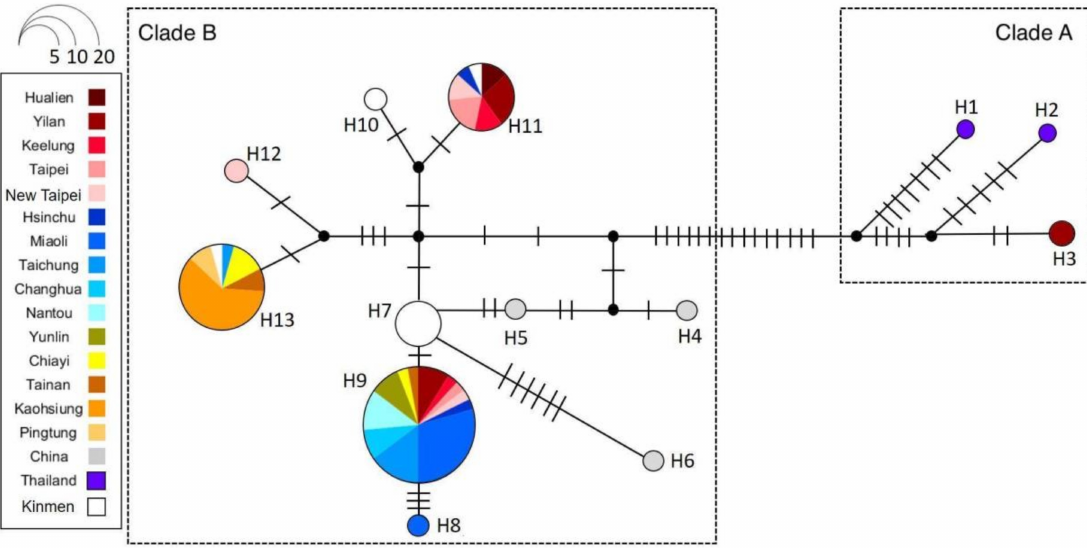
Figure 6. Haplotype network of LSB based on partial mitochondrial COI sequences. Each bar on the branch corresponds to a single nucleotide substitution. Circle area is proportional to the number of individuals carrying a given